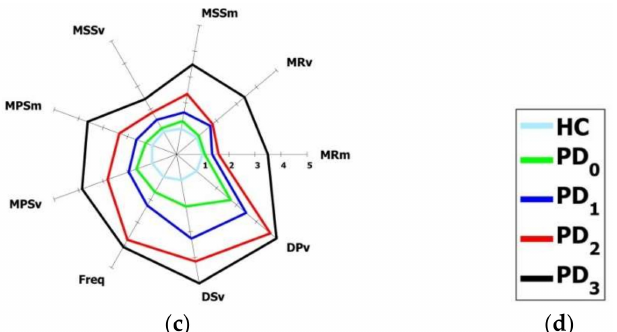
Figure 11. Radar plots of the mean values of the normalized kinematic parameters vs. the UPDRS severity class for the three upper limbs tasks: ( a ) Finger Tapping; ( b ) Opening-Closing; ( c ) Pronation-Supination. ( d ) Radar plots legend with HC and PD severity classes.